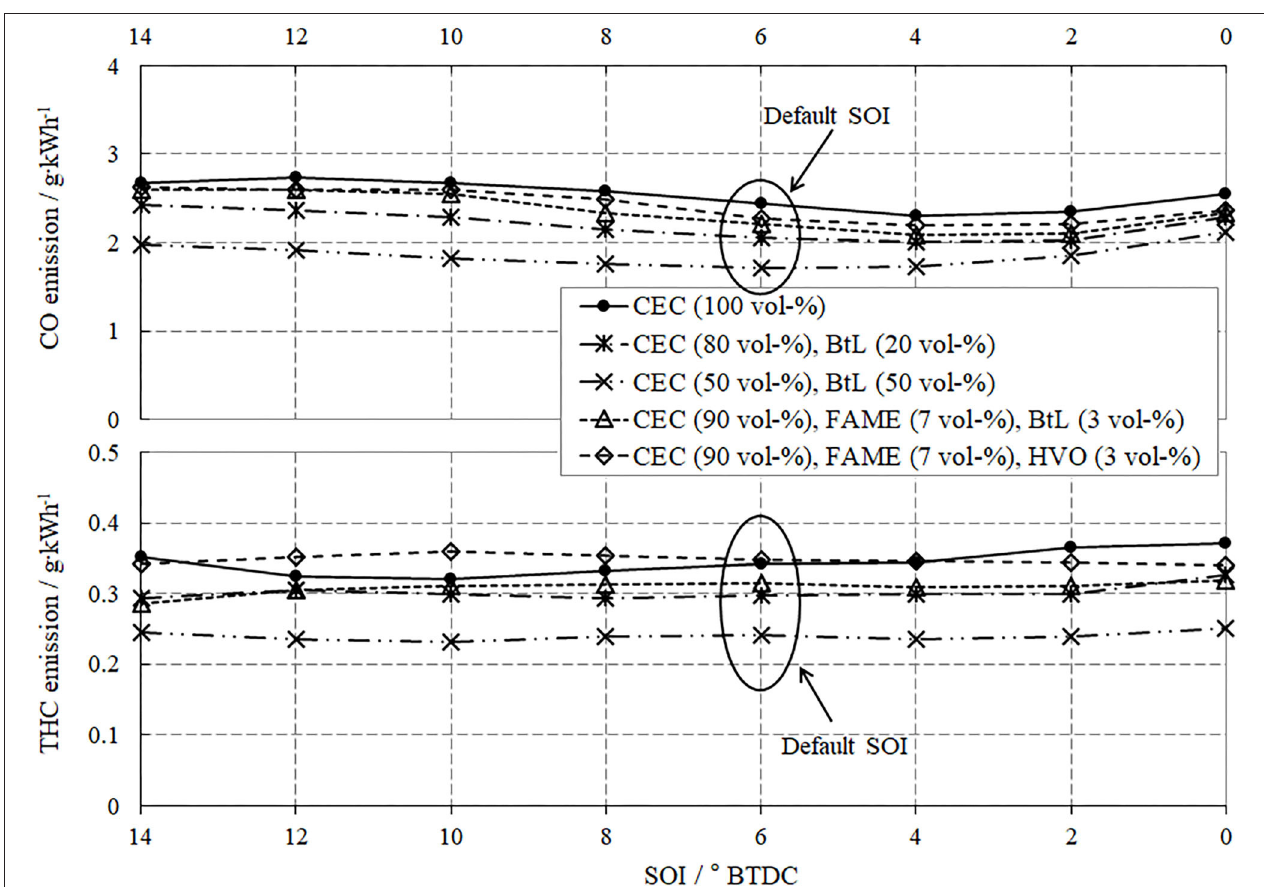
FIGURE 10 | Specific CO- and THC-emissions at 3,000 min − 1 and 8 bar BMEP with varying